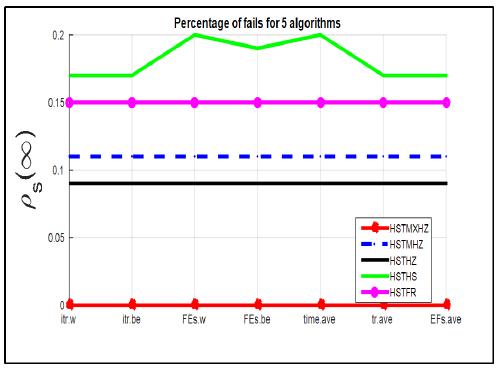
Figure 5. Percentage of fails for all 5 algorithms.